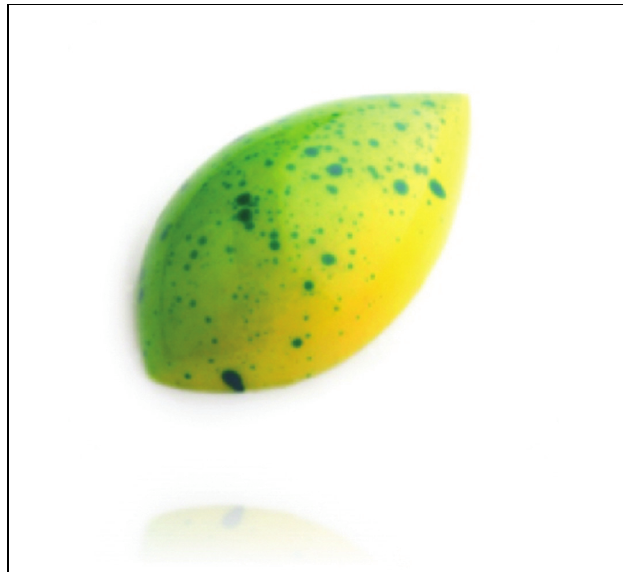
FIGURE 1 | Visual aspect of the chocolate sample that was used in the experiment. Here, it is possible to visualize the external color grade-scale and an overall rounded shape, with pointed tips.